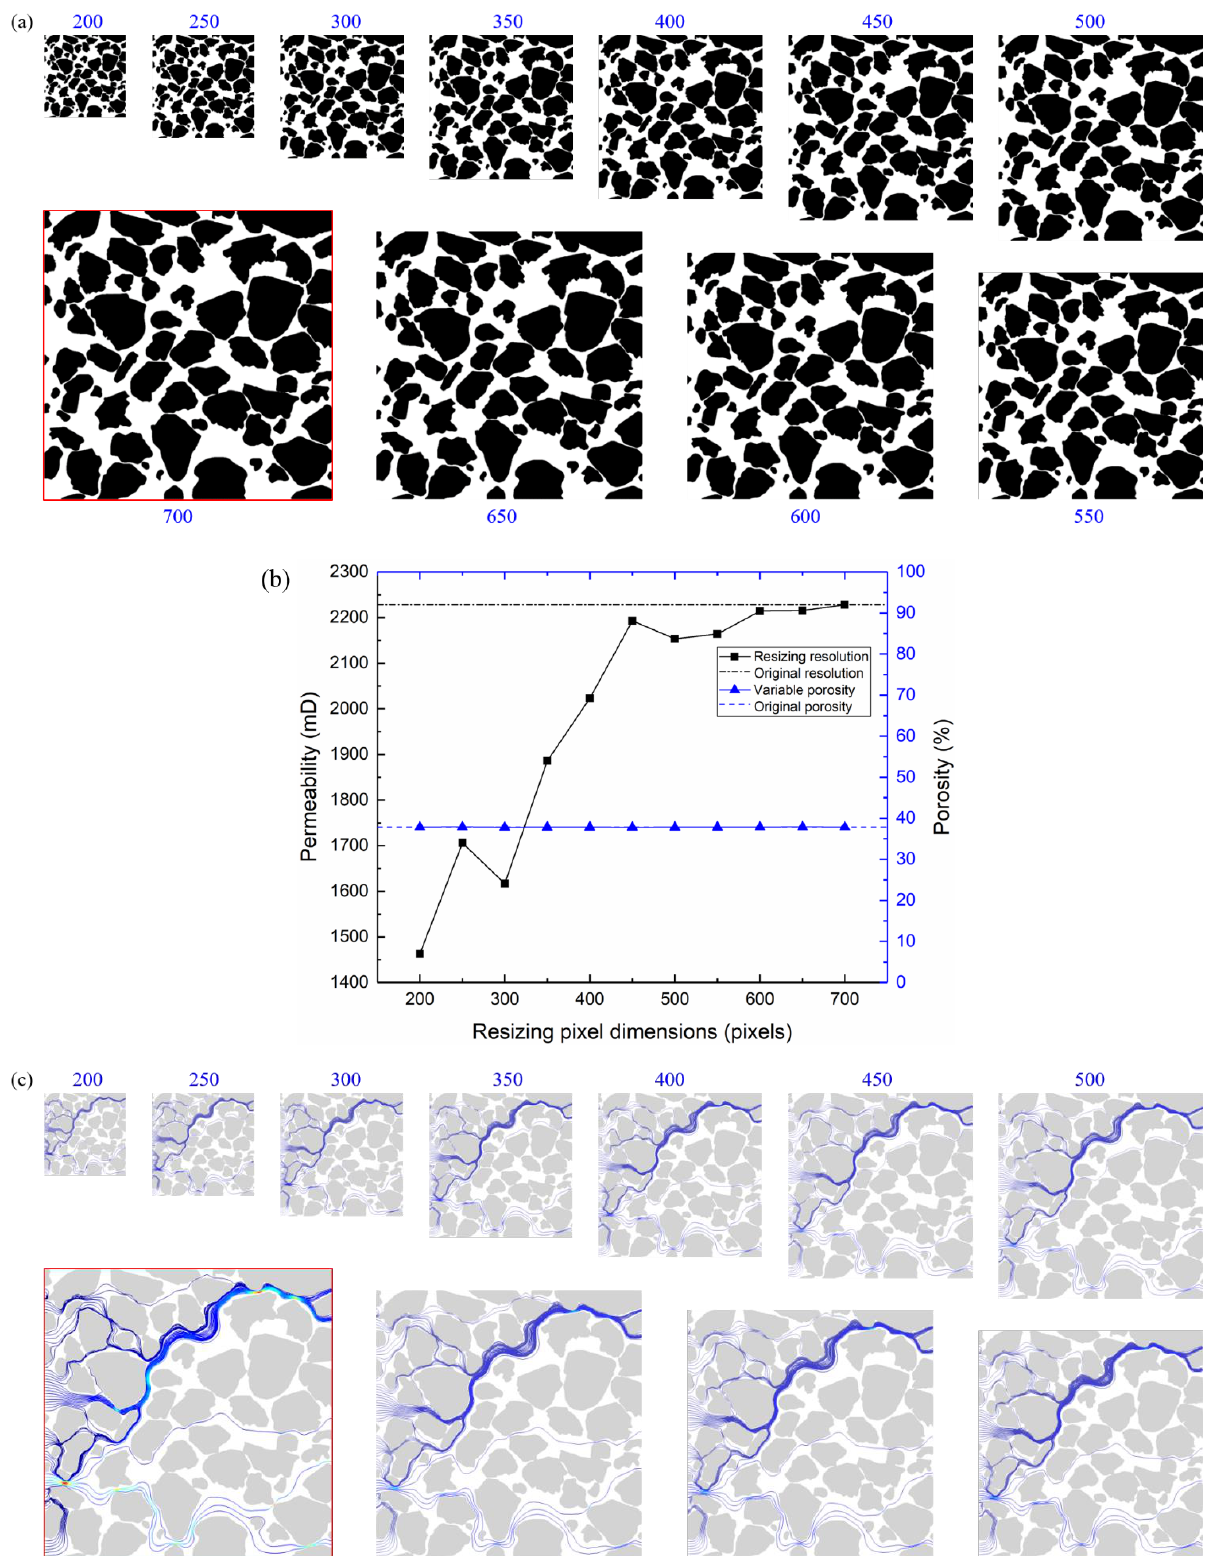
Figure 17. Influence of model resolution on permeability. ( a ) Pore models with different resolution; ( b ) porosity and permeability of pore models with different resolution; ( c ) flow paths and velocity of pore models with different resolution.